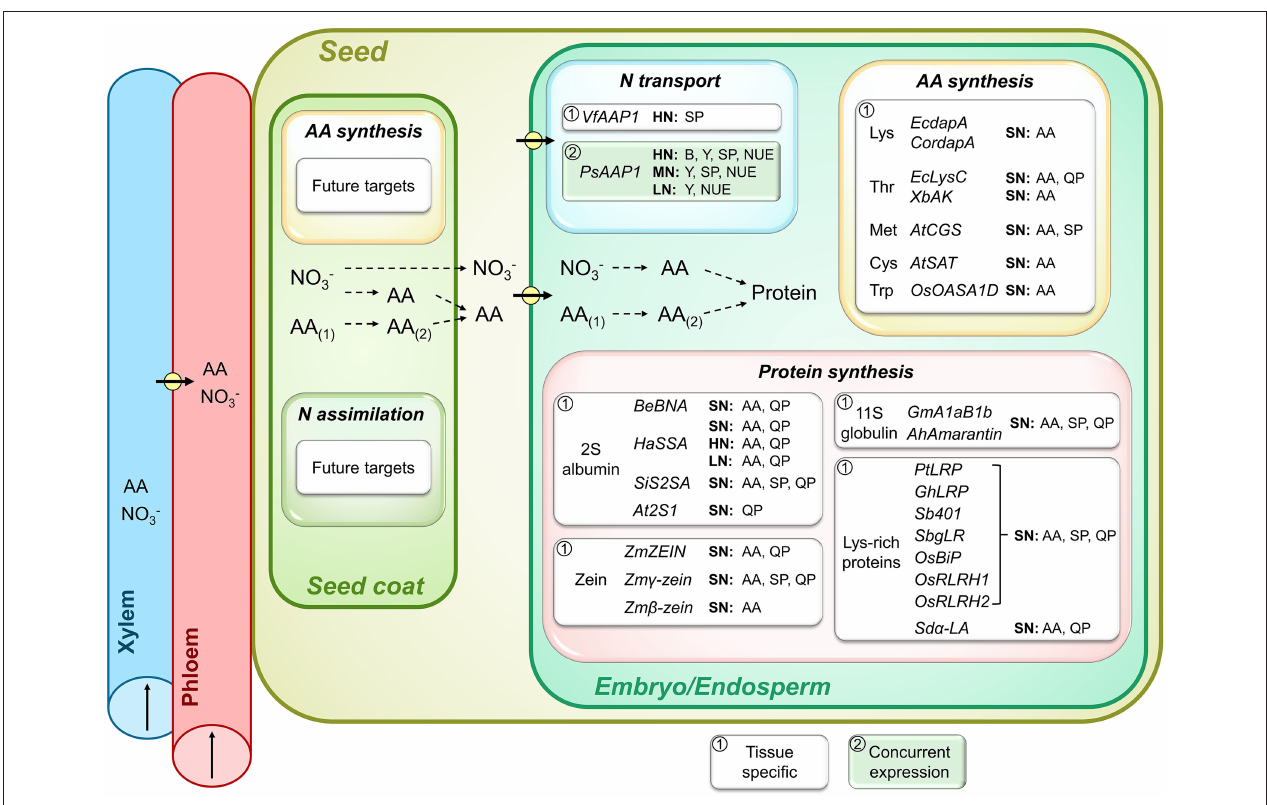
FIGURE 3 | Importance of seed N transport and metabolic processes for seed N accumulation, seed yield, and N use efficiency (NUE). Shown are genes that were successfully overexpressed and resulted in increases in seed levels of specific amino acids (AA), total soluble protein (SP), and specific high-quality proteins (QP), and positively affected shoot biomass (B), seed yield (Y), or NUE. As indicated by a framed white or green background, the transgenic strategies either used (1) seed-specific manipulation or (2) concurrent expression of a particular gene in different source or sink tissues. Plants were grown under high (HN), moderate (MN), sufficient (SN; N supply was not specified), and low N (LN). Pathways of N (re)assimilation, AA synthesis, and conversion (AA (1) to AA (2) ) in seed coat and embryo as well as N import into the embryo (arrows with circle) and subsequent protein synthesis are shown. Arrows in xylem and phloem indicate the direction of translocation. Positive results were achieved for embryo expression of genes encoding for AA transporters ( VfAAP1 , Rolletschek et al., 2005; Weigelt et al., 2008; PsAAP1 , Perchlik and Tegeder, 2017), and genes related to synthesis of sulfur-rich ( AtCGS , Hanafy et al., 2013; Song et al., 2013; Cohen et al., 2014, 2016; AtSAT , Tabe et al., 2010) and other essential AA ( EcdapA , Karachi et al., 1994; Zhu and Galili, 2004; Angelovici et al., 2009; CordapA , Falco et al., 1995; Huang et al., 2005; Frizzi et al., 2007; EcLysC , Karachi et al., 1993, 1994; XbAK , Qi et al., 2011; OsOASA1D , Kita et al., 2010) as well as seed storage protein synthesis ( BeBNA , Altenbach and Simpson, 1989; Altenbach et al., 1992; Pickardt et al., 1995; Saalbach et al., 1995; Demidov et al., 2003 ; HaSSA , Molvig et al., 1997; Tabe and Droux, 2002; Hagan et al., 2003; Chiaiese et al., 2004 ; SiS2SA , Lee et al., 2003, 2005; At2S1 , De Clercq et al., 1990; ZmZEIN , Dinkins et al., 2001; Zm γ -zein , Li et al., 2005; Zm β -zein . Guo et al., 2020c; GmA1aB1b , Takaiwa et al., 1995; Katsube et al., 1999; Momma et al., 1999; AhAmarantin , Rascón-Cruz et al., 2004; PtLRP , Liu et al., 2016; GhLRP , Yue et al., 2014; Sb401 , Yu et al., 2004; SbgLR , Wang et al., 2013b; OsBiP , Yasuda et al., 2009; Kawakatsu et al., 2010; OsRLRH1 and OsRLRH2 , Wong et al., 2015; Sd α -LA , Bicar et al., 2008). Names of genes that were overexpressed are provided, however in contrast to Figures 1, 2 , the transgenic plant species are not indicated as the respective genes have often been overexpressed in multiple species. See the manuscript text or listed references for more detailed information.